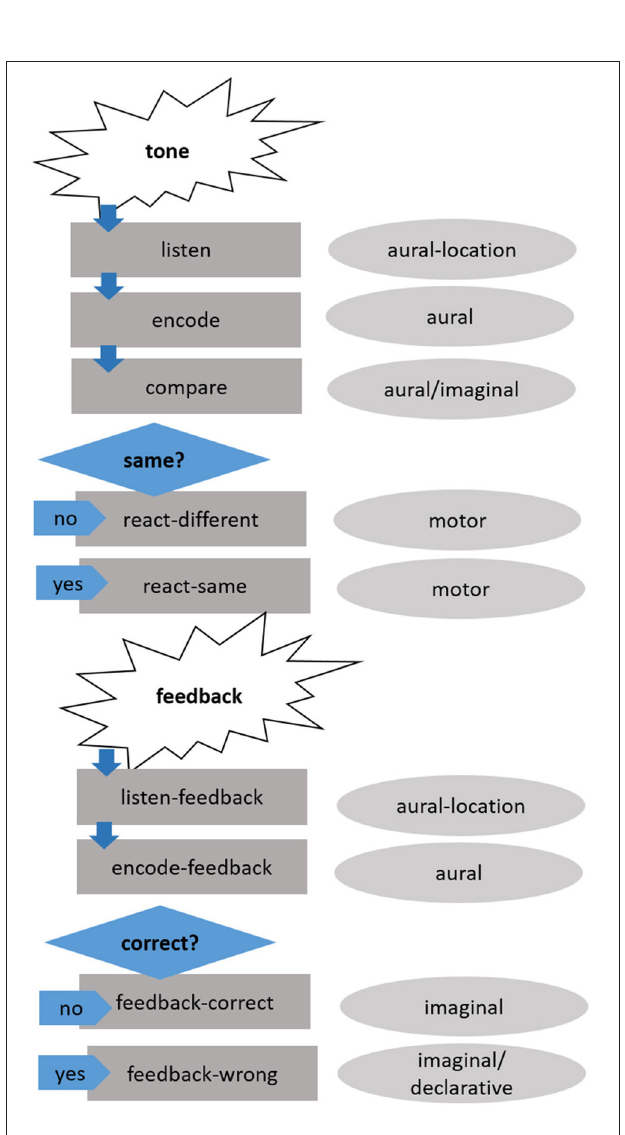
FIGURE 2 | Schematic overview of how the model runs through a trial. The dark-gray boxes on the left represent the production rules, the light-gray ovals on the right the main buffers